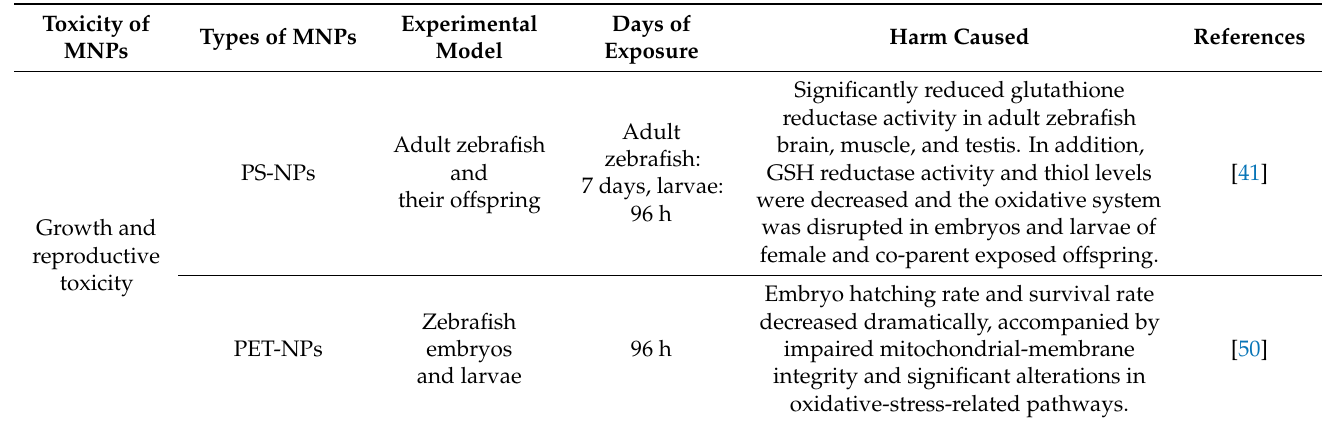
Table 1. Summary table of toxicity caused by different MNPs in